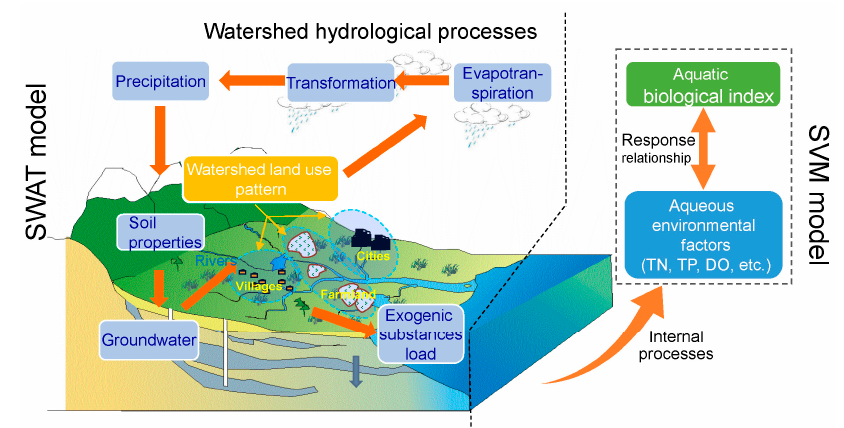
Figure 1. Conceptual diagram of SWAT (soil and water assessment tool) and SVM (support vector machine) model coupling.